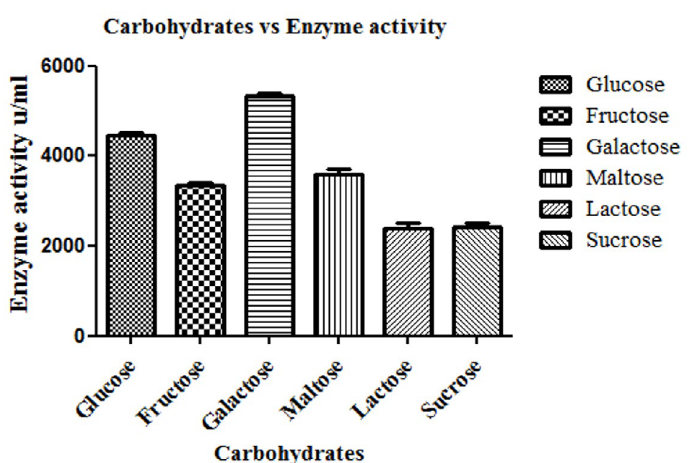
Fig. 3. Effect of different carbohydrates on β-gal production by L. fermentum. Bars show standard deviations with significant difference